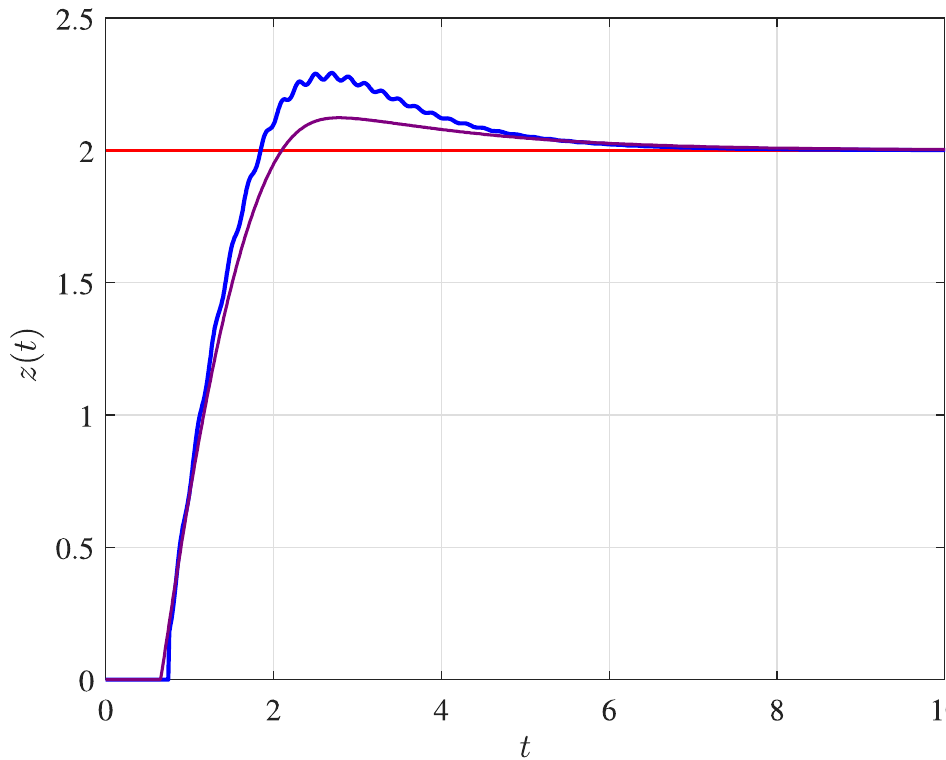
Figure 5. Vertical displacement of the quadrotor, showing the elastic (solid blue line) and rigid (solid purple line) attachments.